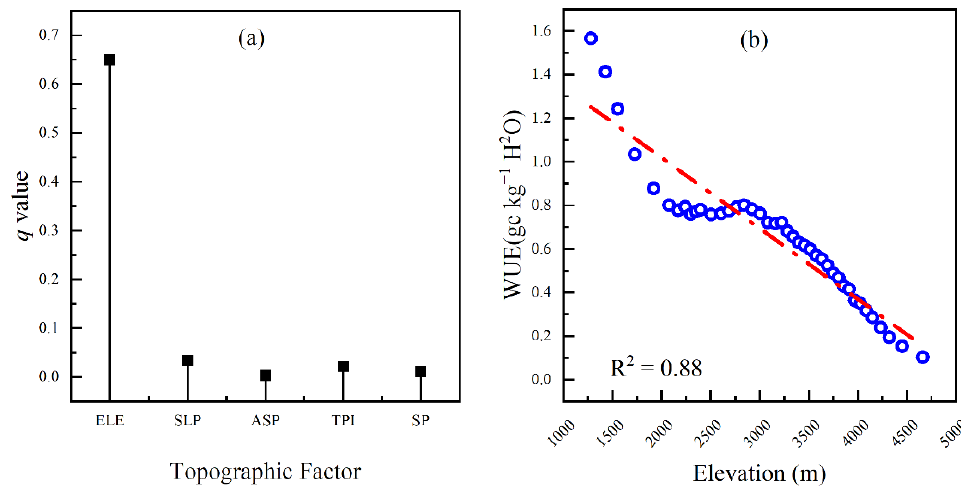
Figure 11. Relationships between topographic factors and WUE. ( a ) q values of the topographic factors, ( b ) the relationship between elevation and WUE. ELE: elevation; SLP: slope; ASP: aspect; SP: slope position; TPI: topographic position index.